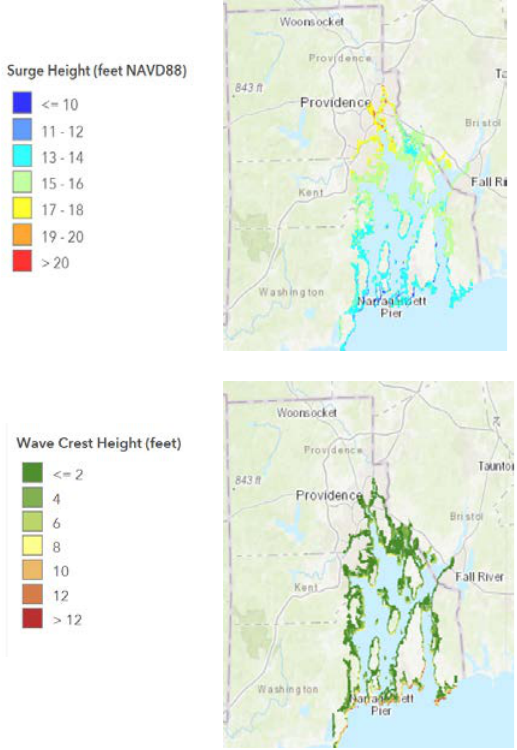
Figure 12. Surge inundation levels (relative to NAVD88) (upper panel) and the wave crest height (lower panel) for Narragansett Bay for 100-yr, no-SLR case.